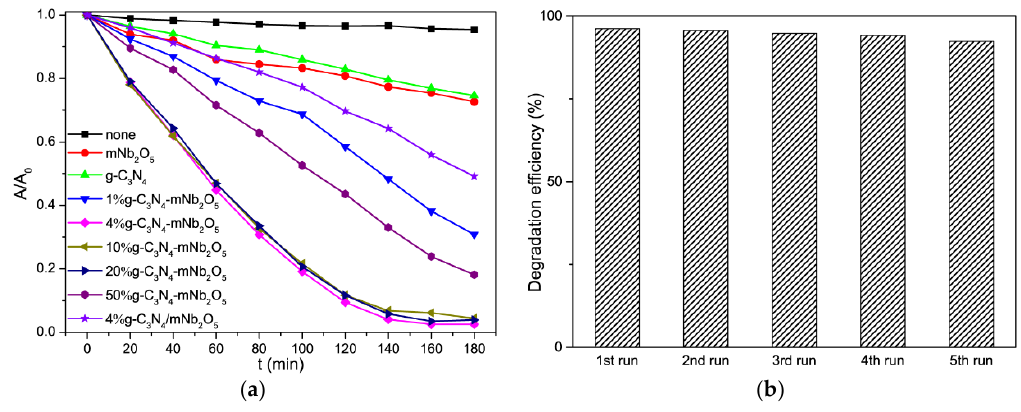
Figure 8. ( a ) Photolysis of RhB and photocatalytic activity over as-prepared photocatalysts for RhB; and ( b ) recyclability for the photodegradation of RhB in the presence of 4% g-C 3 N 4 -mNb 2 O 5 under visible light irradiation.